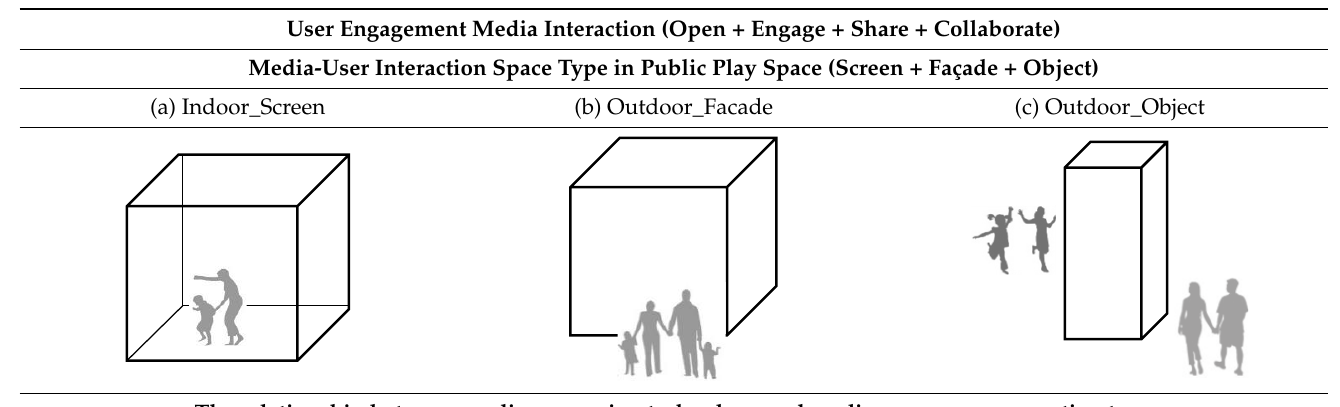
Table 1. Media interaction space type: (A), (B) Two types of (a) screen, (b) façade, (c) object media technology expression analyzed according to physical architecture and object structure form.